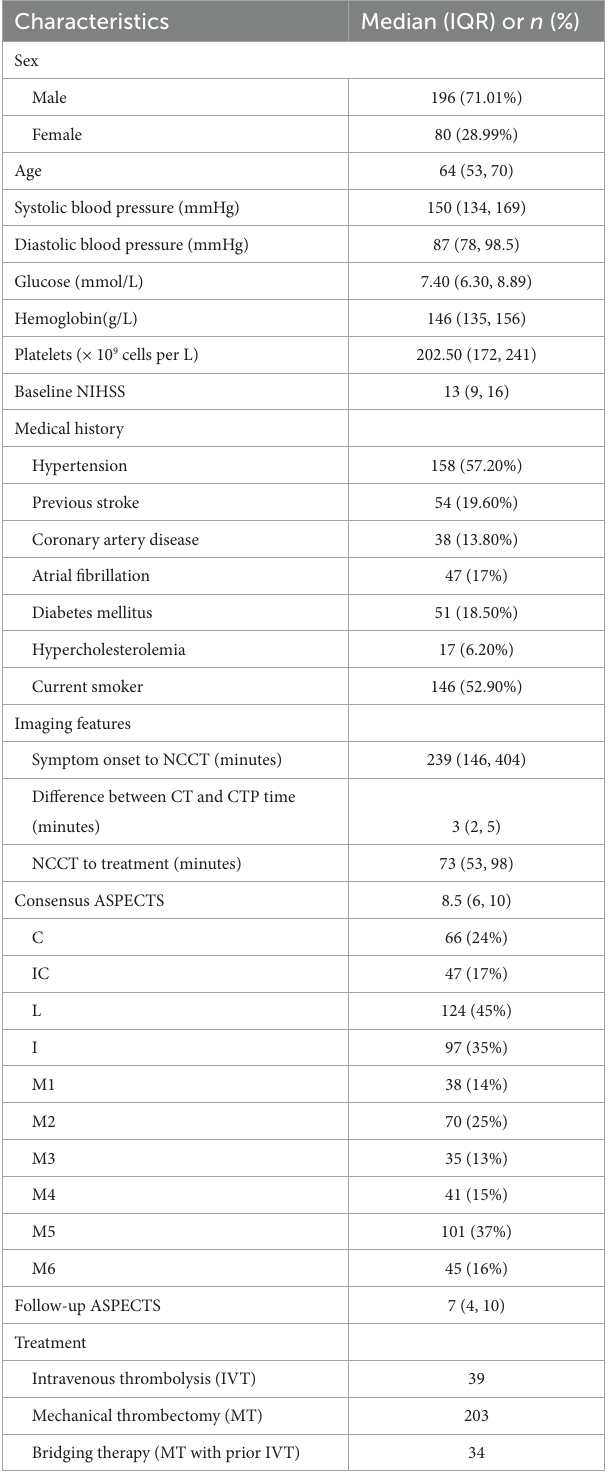
TABLE 1 Clinical and imaging characteristics of the study population.